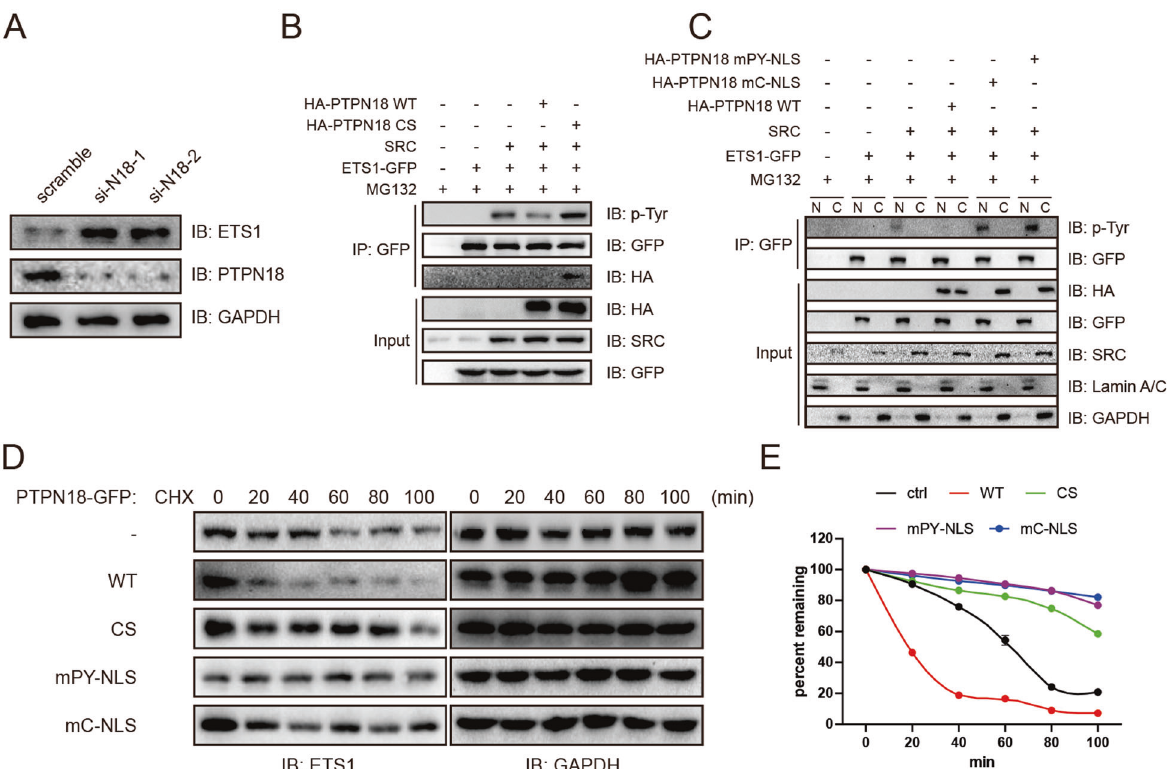
Fig. 4 PTPN18 promotes ETS1 ubiquitination and degradation through regulation of its phosphorylation. A Immunoblot analysis of ETS1 expression after PTPN18 knockdown. B Immunoblot analysis of ETS1 tyrosine phosphorylation after ectopic expression of PTPN18 WT and mutants. Cells were treated with 10 mM MG132 6 h before harvesting. C Immunoblot analysis of ETS1 tyrosine phosphorylation after ectopic expression of PTPN18 WT or cytoplasmic PTPN18. Cells were treated with 10 mM MG132 6 h before harvesting. D Immunoblot analysis of 293 T cells expressing the indicated PTPN18 variants after the addition of 100 mg/ml cycloheximide (CHX). Band intensities at different exposure times were normalized the band intensities of ETS1 at 0 min. E Quanti fi cation of the data in D with